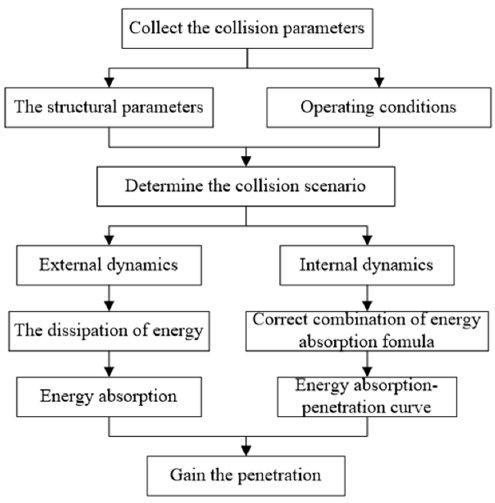
Figure 13. The collision penetration analysis process in the proposed method.